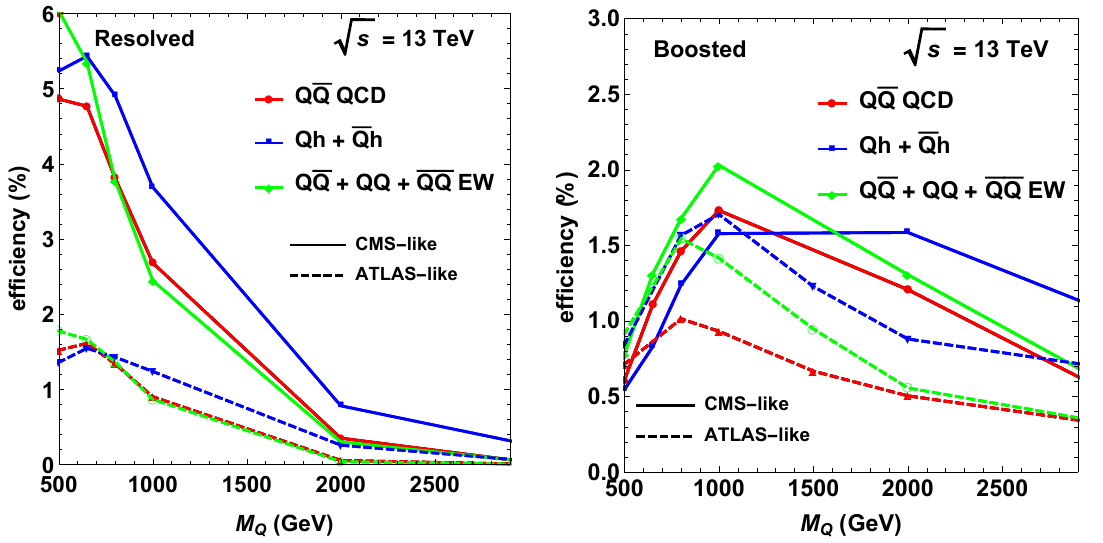
Figure 5 . Selection e(cid:14)ciencies associated with the analyses introduced in section 3.2 and section 3.3 for the resolved (left panel) and boosted (right panel) cases. The CMS-like and ATLAS-like strate- gies are respectively depicted by solid and dotted lines, and the results are based on the (NLO-QCD accurate) simulation of VLQ-induced di-Higgs production in proton-proton collisions at a centre-of- p mass energy of s = 13 TeV. We separately consider the QCD (red) and EW (green) production